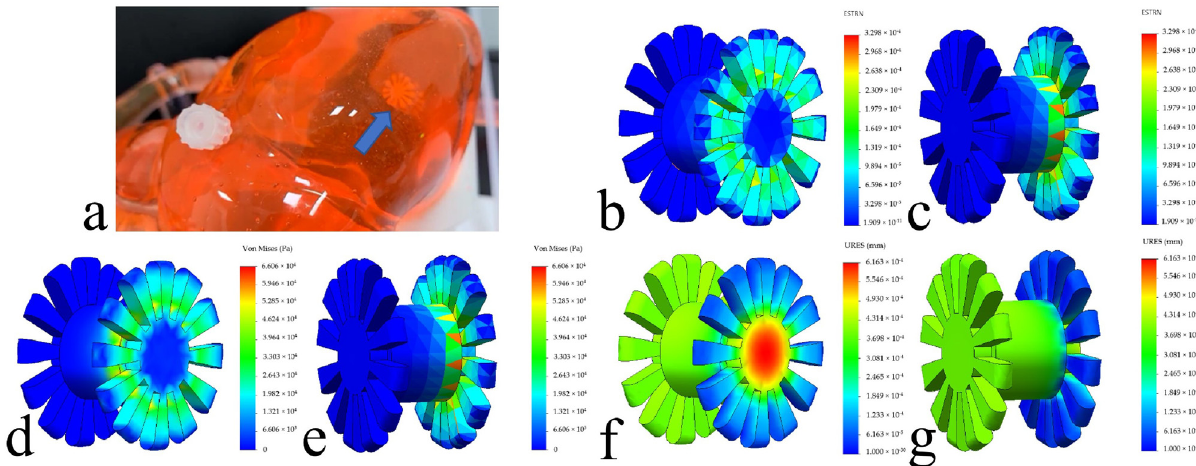
Figure 6: In vitro implantation test and FEA of VSDO: ( a ) in vitro implantation test of VSDO; ( b and c ) cloud image of VSDO strain under boundary conditions; ( d and e ) cloud image of VSDO stress under boundary conditions; and ( f and g ) cloud image of VSDO relative to VSD displacement under boundary